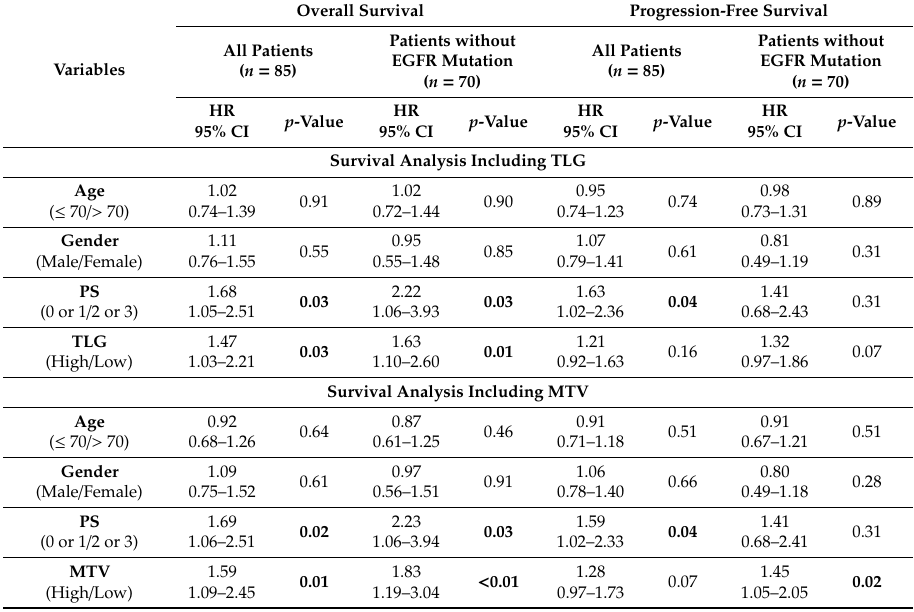
Table 3. Multivariate analysis of overall survival and progression-free